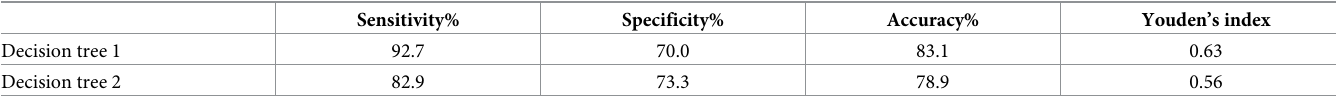
Table 4. Sensitivity, specificity, accuracy and Youden’s index of the two decision